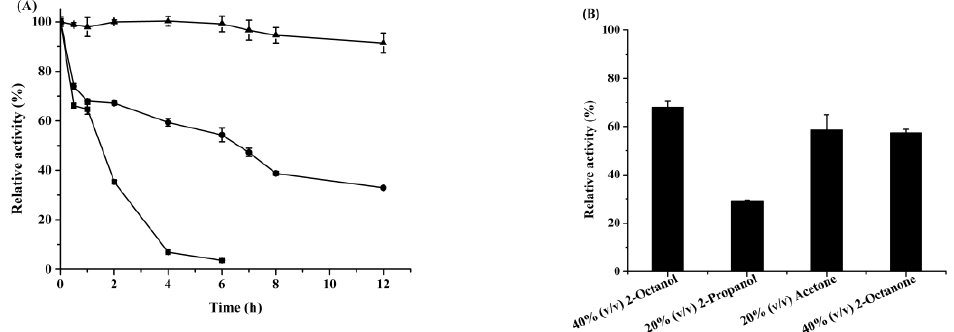
Figure 4. The stability of ReCR against heat ( A ) and organic solvents ( B ). Symbols: ( ■) for 60 °C, ( ● ) for 55 °C, ( ▲) for 35 °C. The relative activity of 100% represents 85.8 U/mg for NBPO reduction. The enzyme was incubated with organic solvent (40% ( v / v ) ( R / S )-2-octanol, 40% ( v / v ) 2-octanone, 20% ( v / v ) 2-propanol, or 20% ( v / v ) acetone) at 35 °C for 3.5 h prior to the stability test against organic solvent.